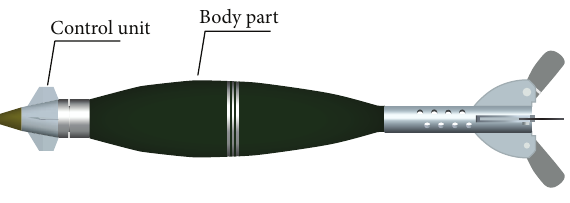
Figure 1: A new concept guided mortars.